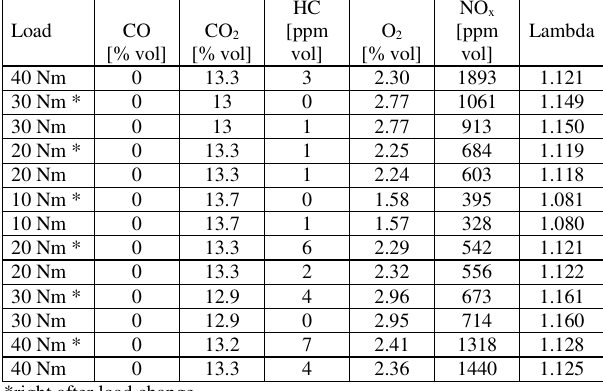
Table 2. Emission of exhaust components measured behind catalytic converter – natural gas powered engine Load CO [% vol]